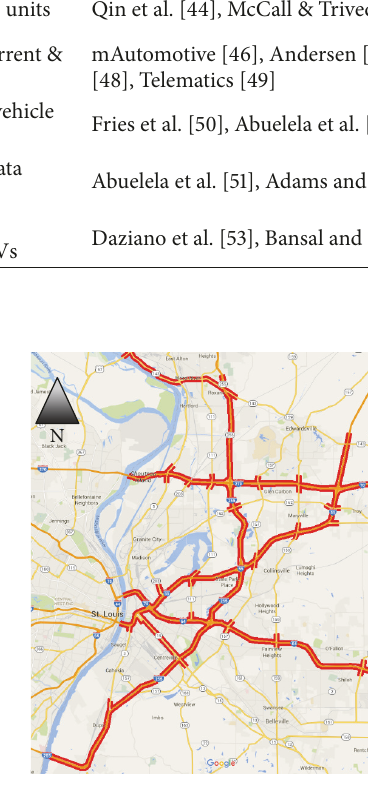
Figure 1: Simulated road network (source: Google Maps). Not to